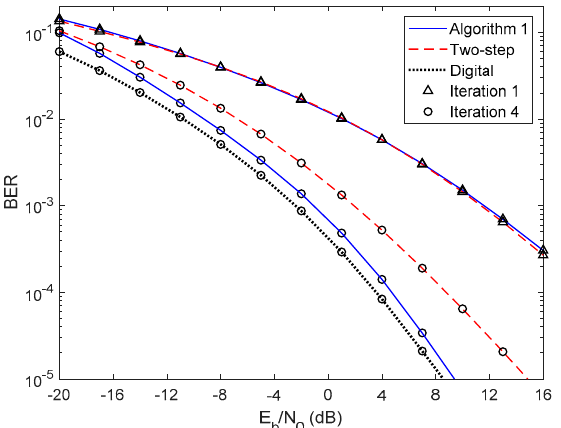
Figure 10. Performance of the proposed hybrid iterative multi-user equalizer (Algorithm 1) for the PCSI precoder with UPA configuration and QPSK modulation.